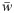
Schematic sketches for the number of successes s and sp expected for a WF wasp and PF wasp to complete in one foraging cycle respectively when the common stomach water level is w.The established average water level of the common stomach is w¯ (arrow), and it is assumed to have a value greater than where max(sp) occurs and has a value less than w = 0.5. The empirical average numbers of successes [26] for a WF wasp and PF wasp (5.2 and 6.4 respectively) occur at water levels greater and less than the average w¯ respectively (this is deduced from the hypothesized shapes of the curves). Note that s = 5.2 might occur below, at, or above w = 0.5. Also, sp = 6.4 occurs at a water level nearer to the average w¯ than does s = 5.2. Note that w¯ is located under a steeper section of y = sp(w) than of y = s(w), so that the deviation in sp is greater than the deviation in s (4.3 > 2.8) in agreement with empirical findings of Karsai and Wenzel [26].